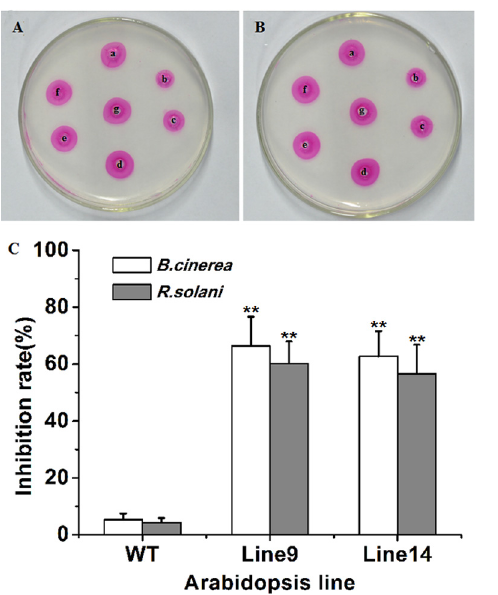
Fig 8. Inhibitory activity of crude protein extracts from wild type and transgenic Arabidopsis. Inhibitory activity was measured against Botrytis cinerea ( A ) and Rhizoctonia solani polygalacturonase ( B ). a-c, 15 μ L crude enzyme + 15 μ g crude protein extract from wild type and transgenic Arabidopsis lines 9 and 14; d-f, 15 μ L crude enzyme + 15 μ g heat-denatured crude protein extract from wild type and transgenic Arabidopsis lines 9 and 14; g, crude PGs. C. Inhibition rate of crude protein extracts from wild type and transgenic Arabidopsis. Error bars indicate standard error (n = 3). ** , P < 0.01 by least significant difference against wild